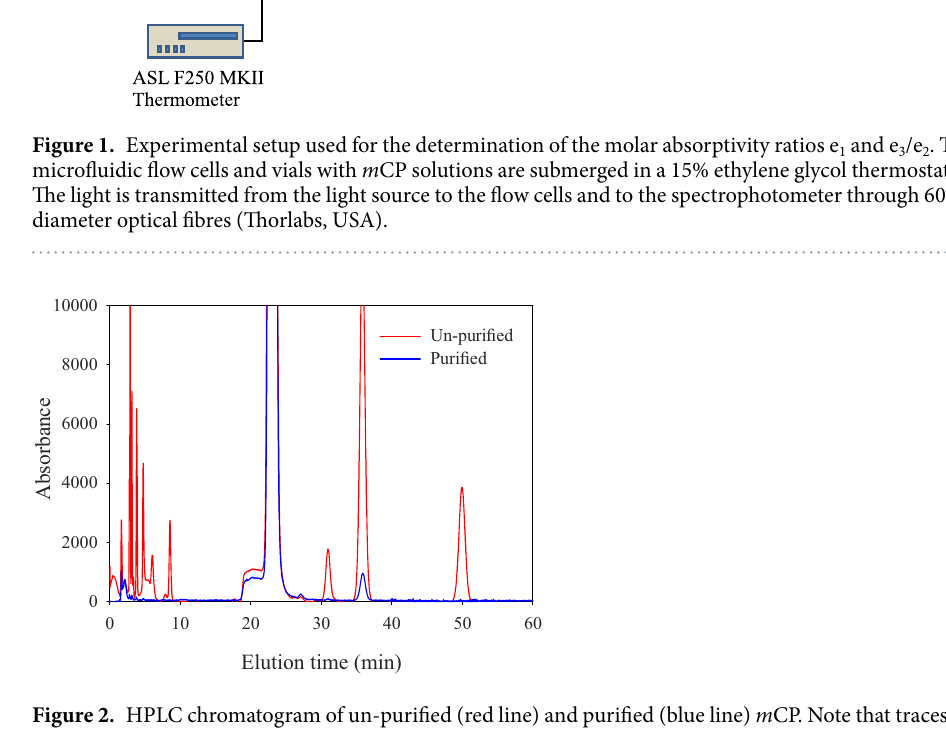
Figure 2. HPLC chromatogram of un-purified (red line) and purified (blue line) m CP. Note that traces of a component eluted at approximately 36 minutes are still present in the purified